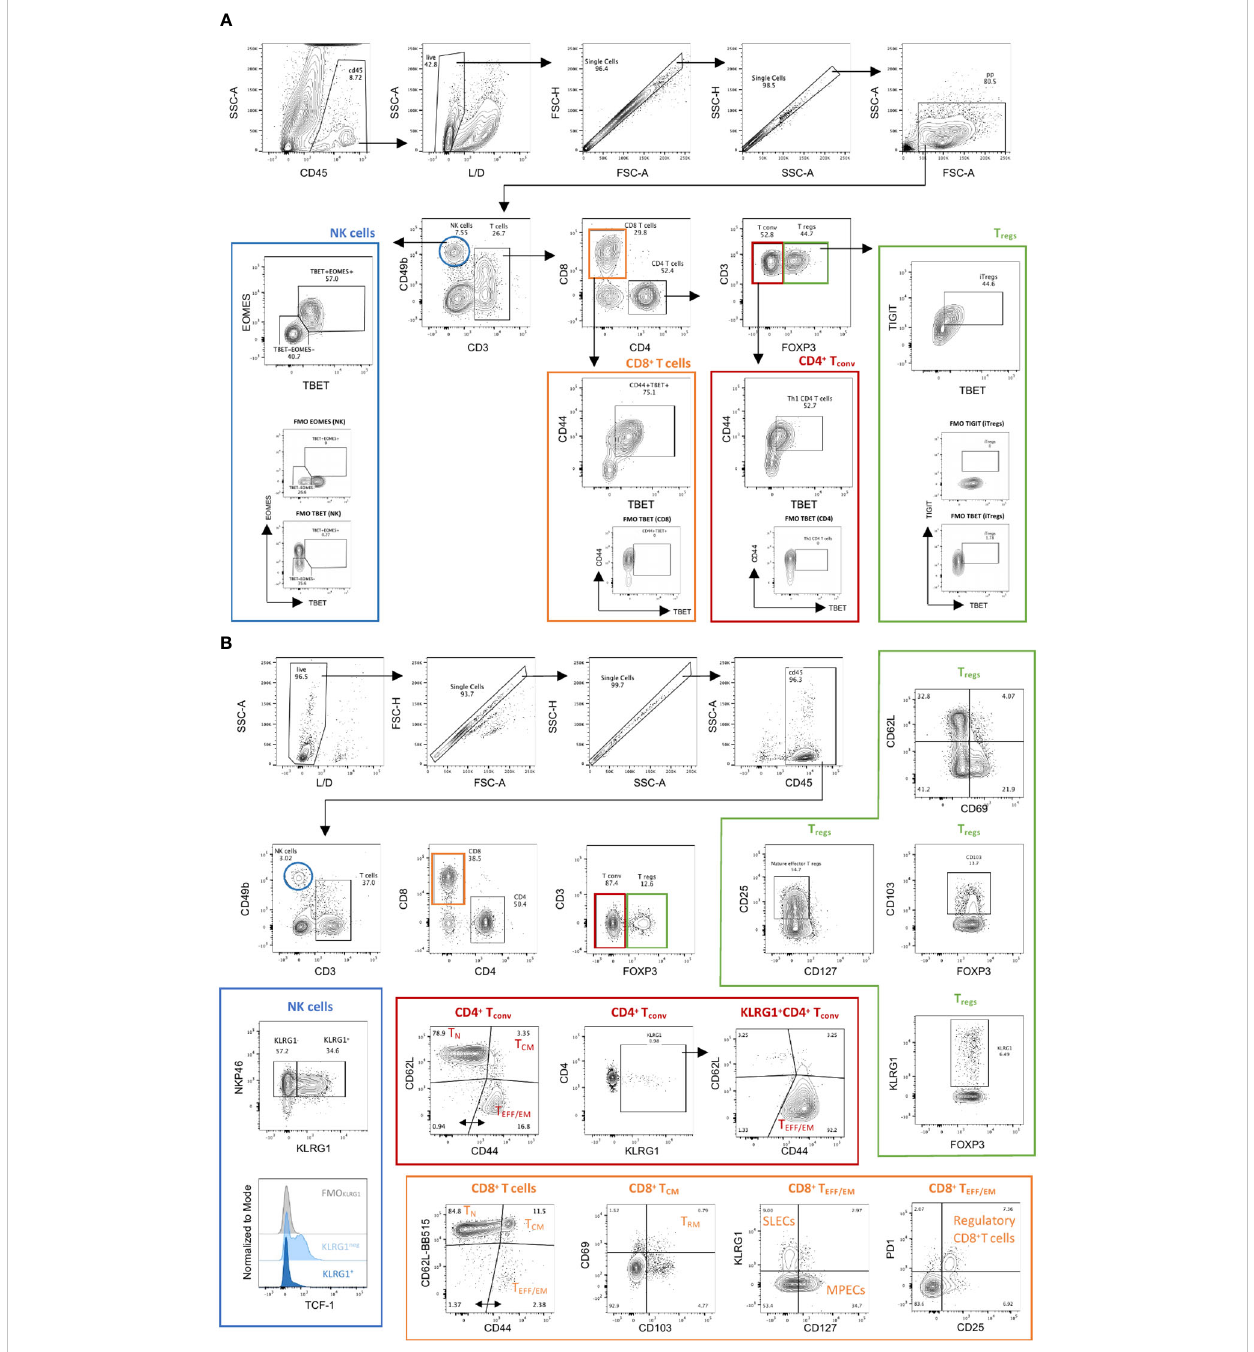
FIGURE 2 Manual gating strategy in Panels 1 & 2. (A) Panel 1. Tumor in fi ltrating immune cells from YUMM UV 1.7 tumors were identi fi ed through exclusion of non-viable and CD45 − cells, followed by use of physical parameters to distinguish lymphocytes and exclude doublets. Main immune cell subsets were de fi ned as follows: natural killer cells (blue; NK; CD3 − CD49b + ); conventional CD4 + T cells (red; CD4 + Tconv; CD3 + CD4 + FoxP3 − ); regulatory CD4 + T cells (green; Treg; CD3 + CD4 + FoxP3 + ) and CD8 + T cells (orange, CD3 + CD8 + ). Examples of additional subpopulations are also indicated as follow: differentiated and cytotoxic NK cells (T-bet + Eomes + ); Th1 CD4 + T cells (CD4 + CD44 + T-bet + ); induced Tregs (iTregs: CD4 + FoxP3 + T- bet + TIGIT + ); Effector CD8 + T cells (CD8 + CD44 + T-bet + ). Fluorescent minus one (FMOs) for Eomes, T-bet and TIGIT are also shown. (B) Panel 2. Spleens isolated from C57Bl/6 mice bearing YUMM UV 1.7 melanomas were processed as described in methods. Immune cells were identi fi ed through exclusion of non-viable and CD45 − cells; followed by use of physical parameters to distinguish lymphocytes and exclude doublets. Main immune cell subsets were de fi ned as in ( A ). Examples of additional subpopulations are also indicated as follow: mature and differentiated NK cells (NKp46 + KLRG1 + ); Naïve (T N : CD62L + CD44 - ), central memory (T CM : D62L + CD44 + ) or effector/effector memory (T EFF/EM : CD62L - CD44 + ) CD4 + and CD8 + T cells; Cytotoxic CD4 + T cells (CD4 + FOXP3 - KLRG1 + ); Tissue resident memory CD8 + T cells (T RM: CD69 + CD103 + CD8 + T CM ); short lived effector cells (SLECs: KLRG1 + CD127 - CD8 + T EEF/EM ) and memory precursor cells (MPECs: KLRG1 - CD127 + CD8 + T EEF/EM ); regulatory CD8 T cells (PD1 + CD25 + CD8 + T EEF/EM